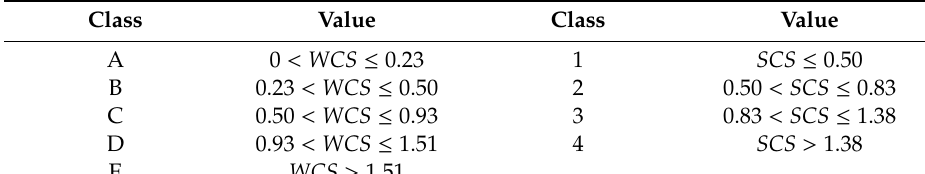
Table 4. Climate classification related to winter climate severity (WCS) and summer climate severity (SCS).